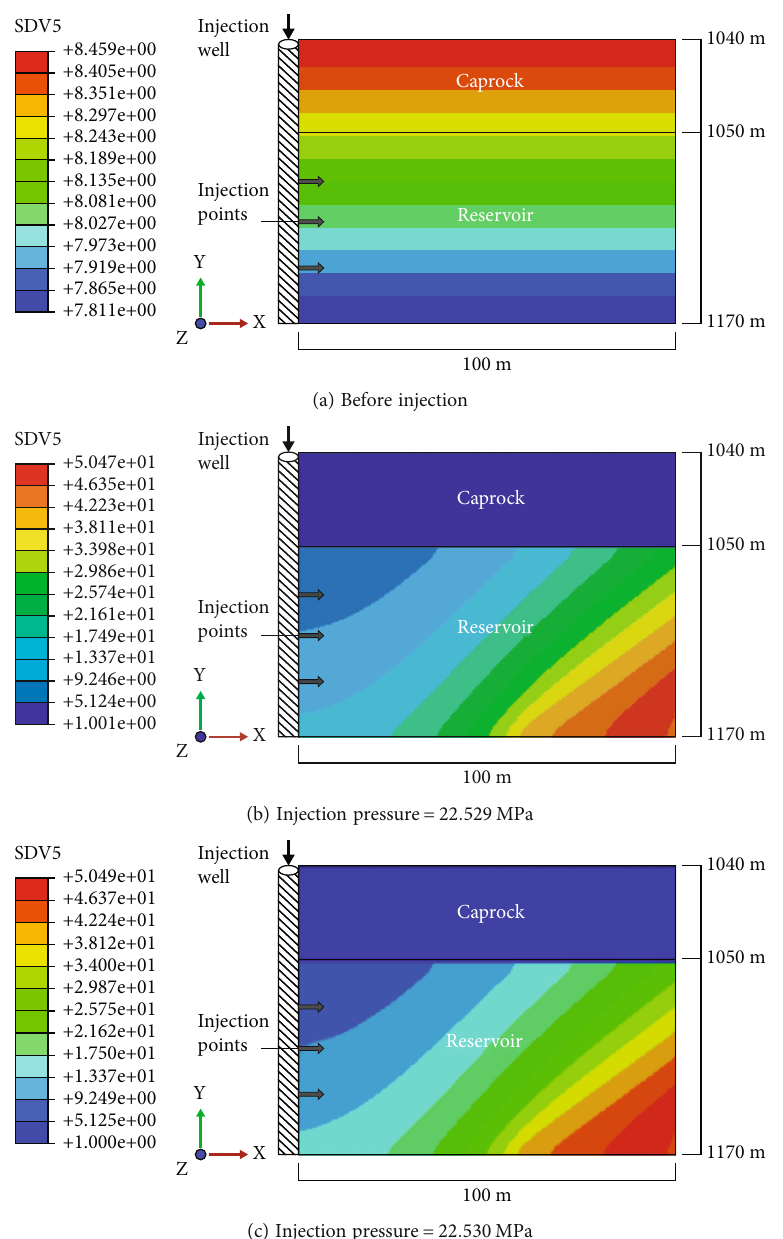
Figure 8: Nephogram of damage state before and 1 year after